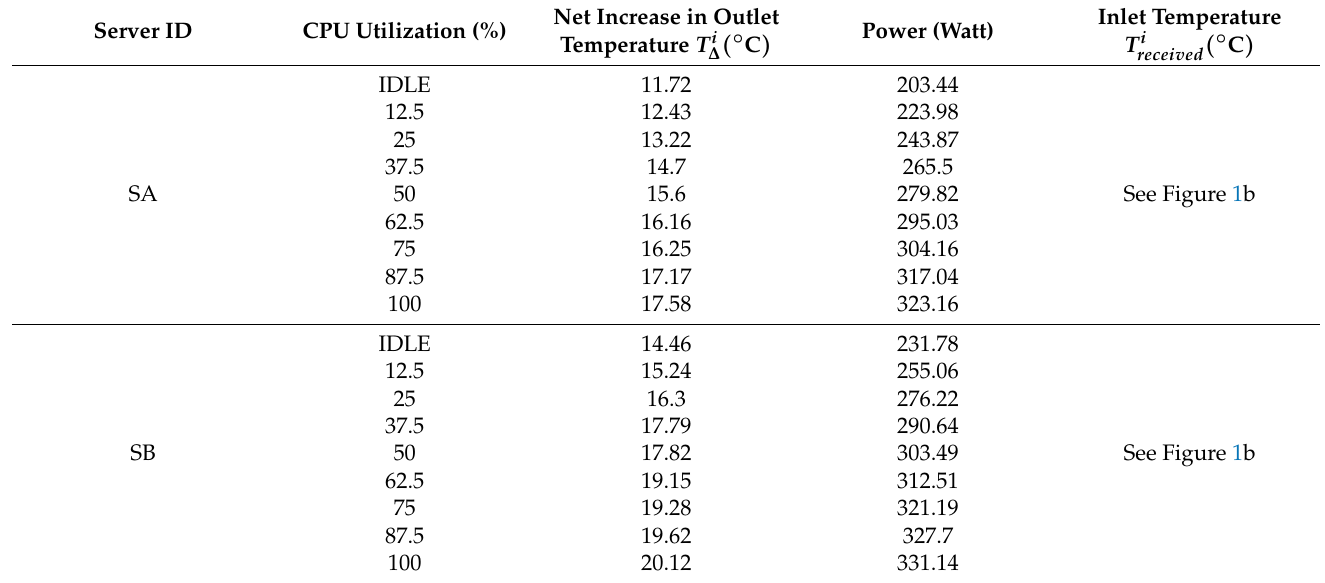
Table 3. A sample thermal profile of a